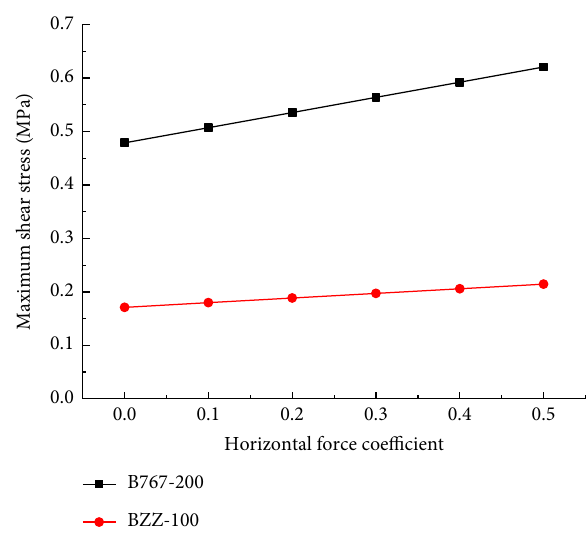
Figure 4: Effect of resilience modulus of overlay on maximum shear stress.